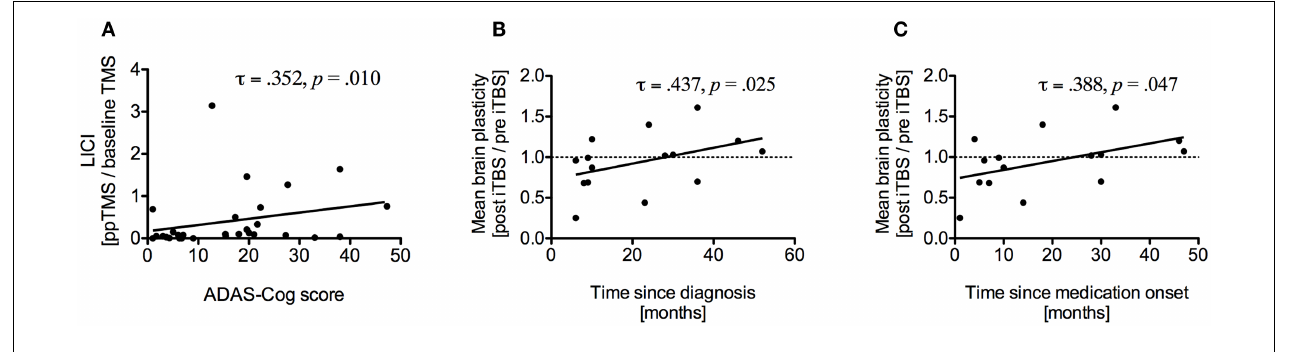
within 90min after intermittent theta burst stimulation (iTBS) and time since diagnosis. (C) Correlation between average brain plasticity and time since medication